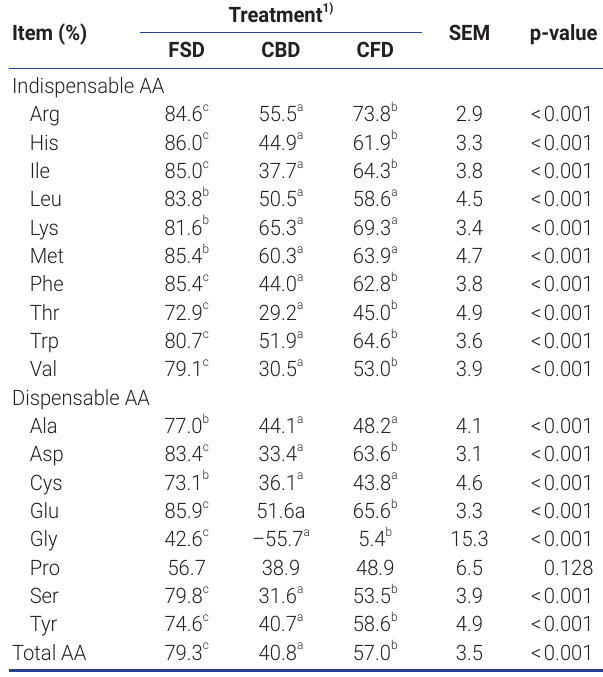
Table 4. Apparent ileal digestibility of amino acids in experimental